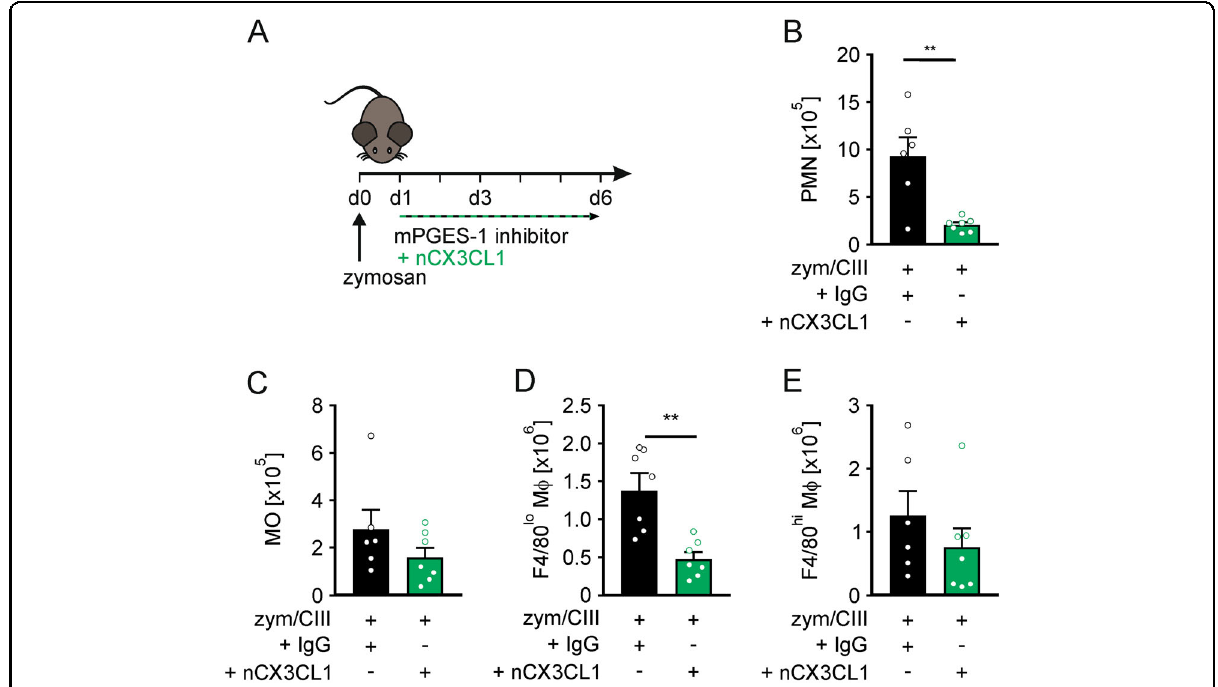
Fig. 5 CX3CL1 elevates macrophage numbers during resolution of peritonitis upon mPGES-1 inhibition. A Schematic representation of the in vivo CX3CL1-neutralization approach. Starting 24 h post i.p. zymosan (5 mg/kg) injection, mice received daily i.p. injections of the mPGES-1 inhibitor compound III (CIII) (25 mg/kg) in combination with a CX3CL1 neutralizing antibody (nCX3CL1, 5 µg) or the respective IgG control (IgG). Numbers of viable B PMNs (CD11b + , Ly6G + ), C monocytes (MO; Ly6G lo , F4/80 lo , MerTK lo , MHCII - ), D F4/80 lo (Ly6G lo , F4/80 lo , MerTK lo ), and E F4/80 hi (Ly6G lo , F4/80 hi , MerTK hi ) macrophages (M ϕ ) in the peritoneum at day 6 were analyzed by FACS. Data are presented as means ± SEM ( n ≥ 6) and were statistically analyzed using t test (** p <